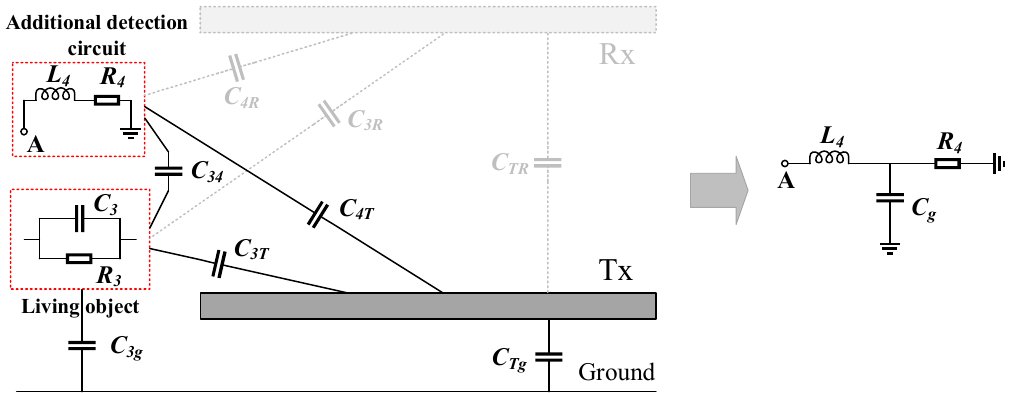
Figure 14. Equivalent circuit of a detection coil considering the effect of a living object.